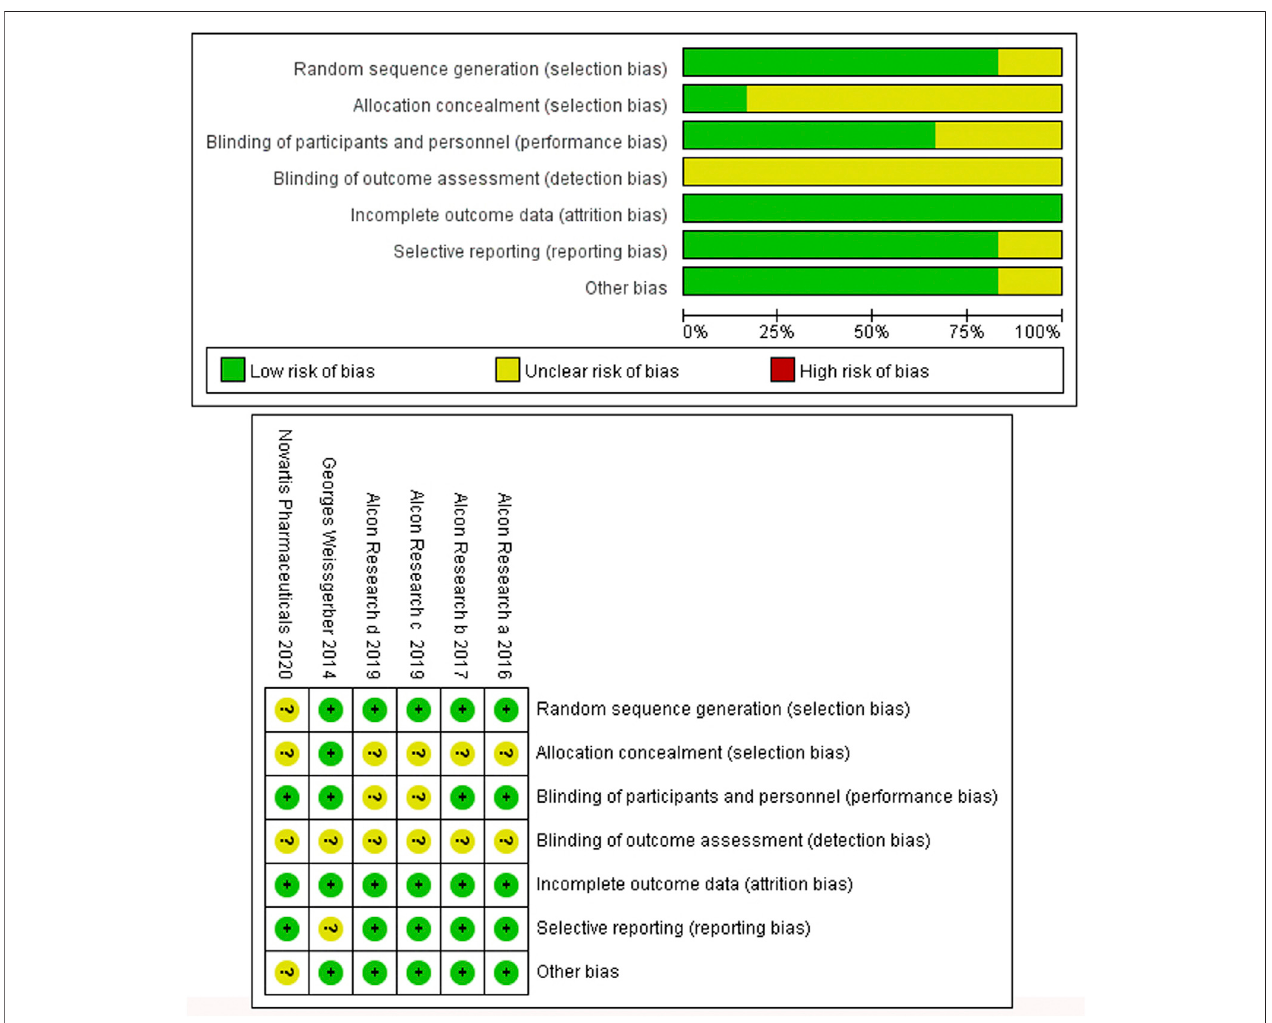
FIGURE 2 | Risk of bias graph (A) and Risk of bias summary (B)